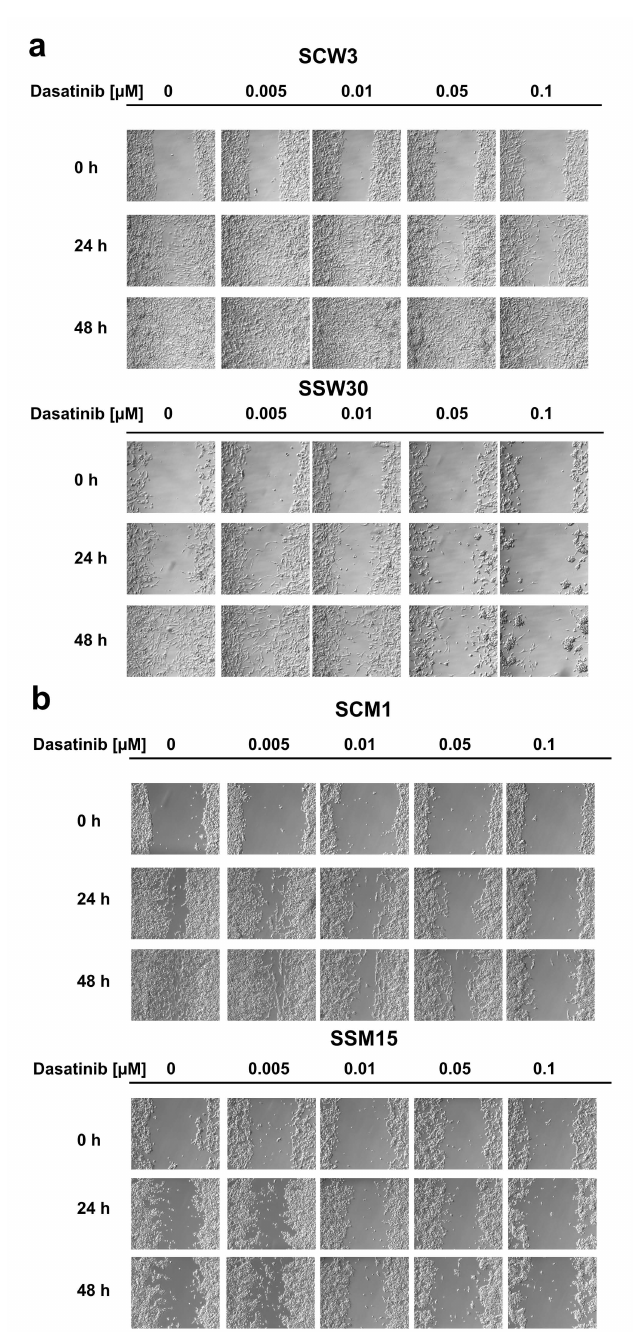
Figure 3. Treatment with dasatinib impairs the migration of melanoma cells based on the scratch assay. ( a ) Image from a single representative experiment performed using WM853 SCW3 and SSW30 clones. ( b ) Image from a single representative experiment performed using MDA-MB-435S SCM1 and SSM15 clones. Quantification of above results is shown in the Figure S4. 10 × 10